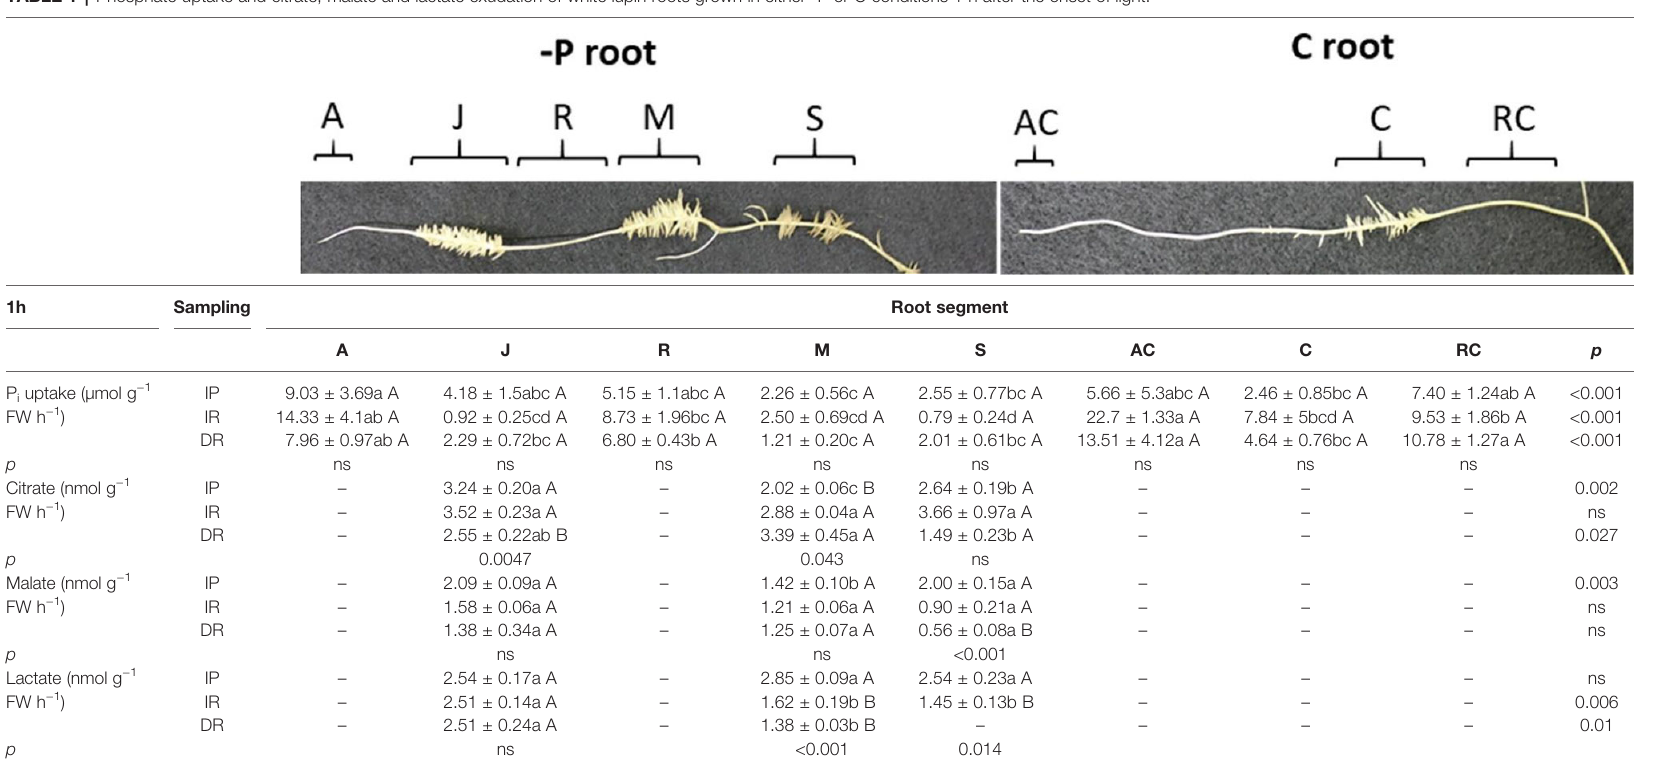
TABLE 1 | Phosphate uptake and citrate, malate and lactate exudation of white lupin roots grown in either -P or C conditions 1 h after the onset of light.